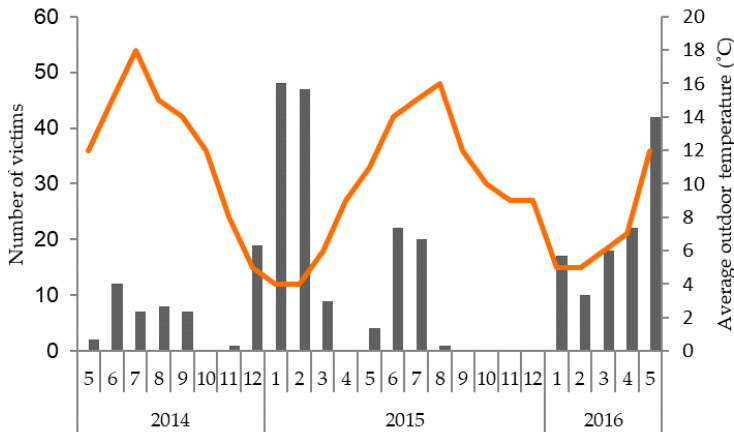
Figure 2. Number of cases of lethal gang aggression ( n = 316) from 2014–2016 (months on the x -axis) at the focal farm for which accurate mortality data were available. This farm reported 2.6% mortality due to gang aggression. The secondary axis shows the average monthly outdoor temperature (in degrees Celsius) for the farm location.